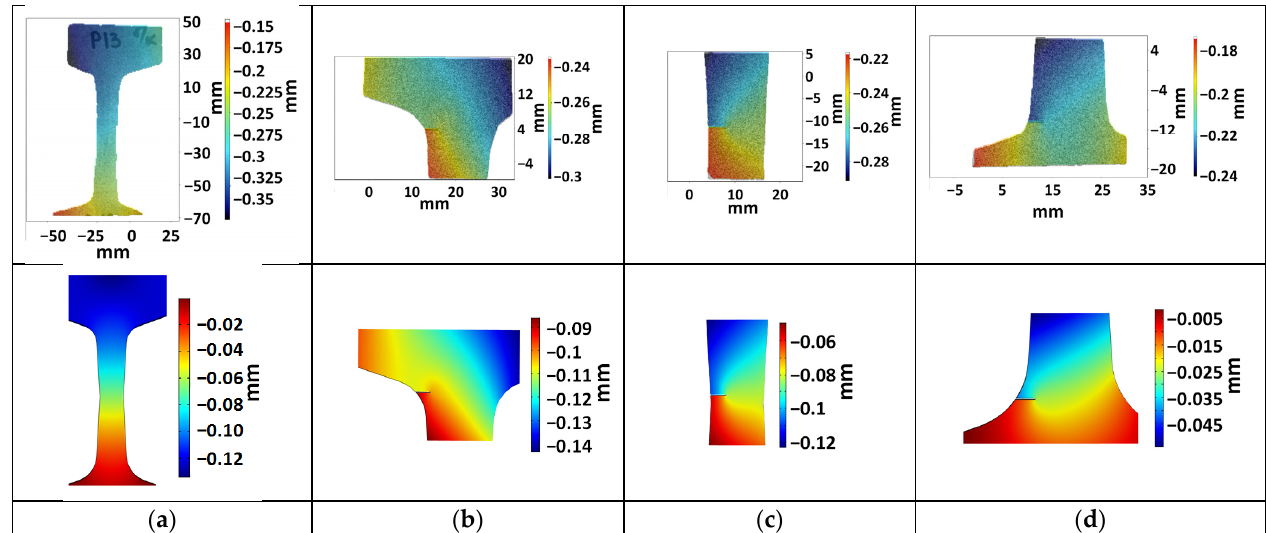
Figure 5. Displacement distributions obtained by DIC (upper row) and FEM (lower row) for the sample without incision ( a ) and with incision in the head ( b ), web ( c ) and foot ( d ) of the rail .